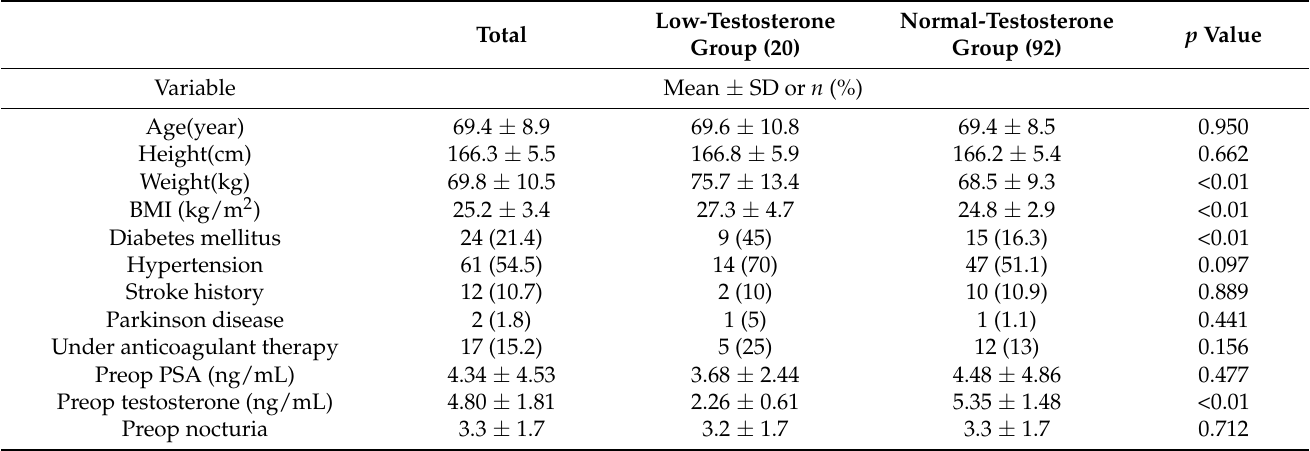
Table 1. Demographic data of the low- and normal-testosterone groups. Low-Testosterone Normal-Testosterone Total Group (20)